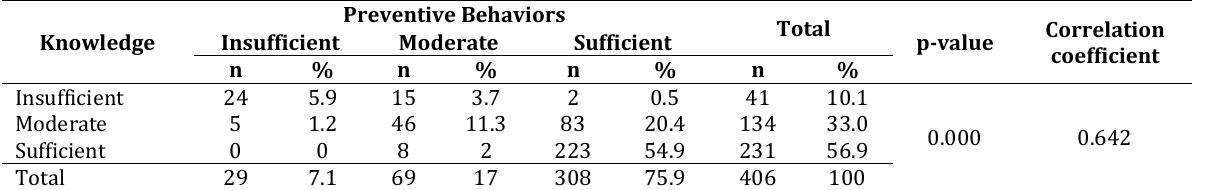
Table 4. The Relationship between Knowledge Level and Preventive Behavior against